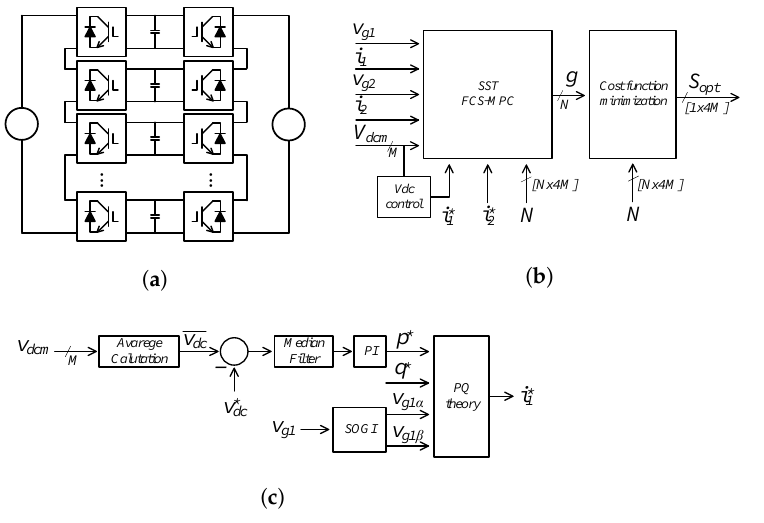
Figure 11. Generic M -modules ISOS CHB-B2B converter: ( a ) topology configuration, ( b ) MPC diagram block, ( c ) primary side current reference